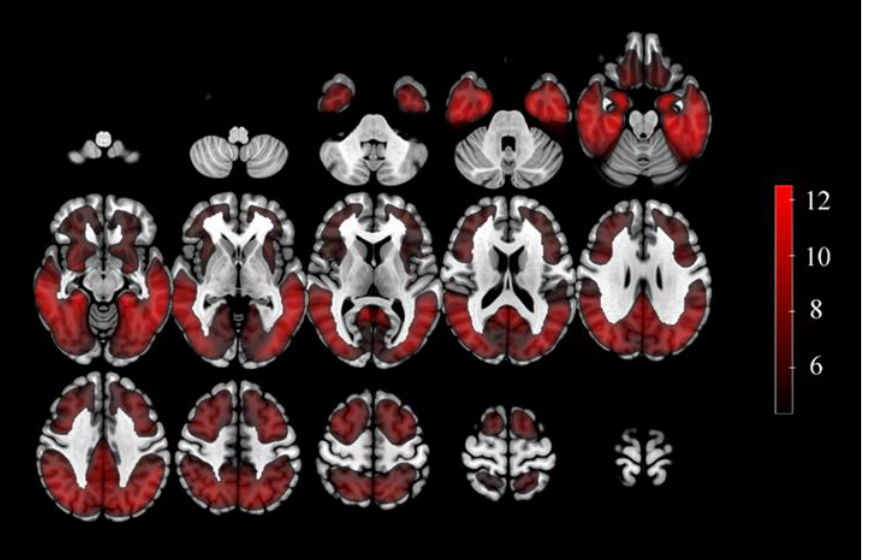
Figure 2. The ROIs related brain regions defined by a two-sample t test between AD and NC from ANDI training datasets. Color bars represent t value. ROIs: Regions of interest.